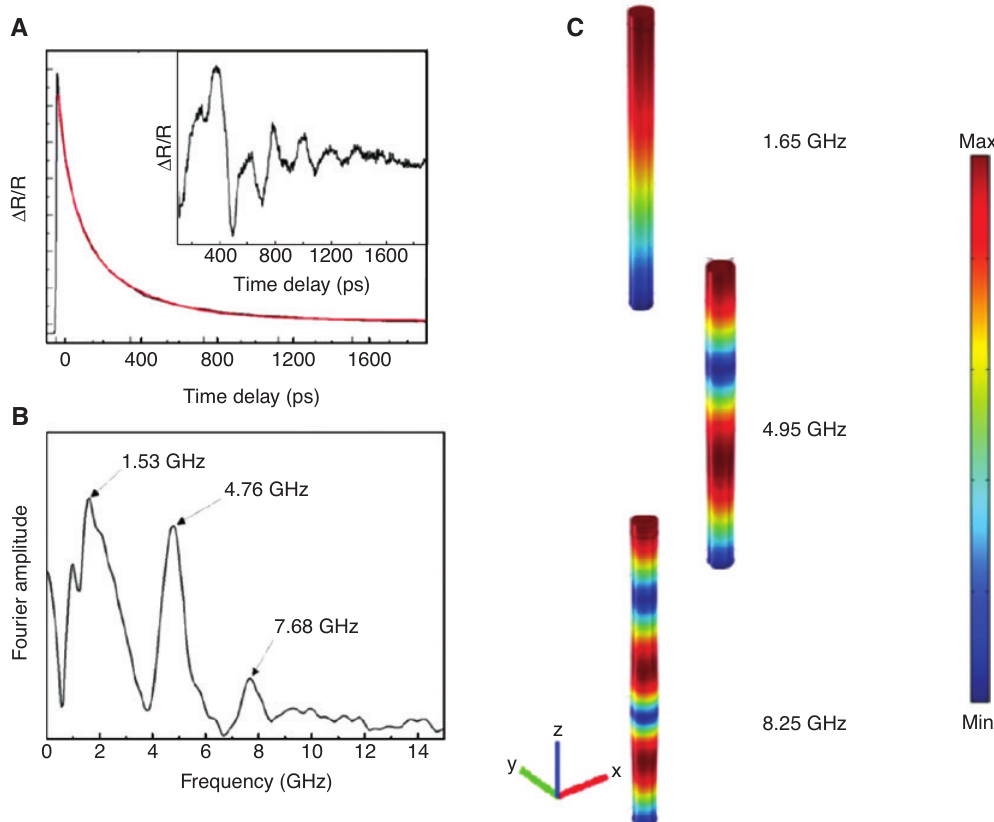
Figure 13: Extensional modes of GaN nanowires. (A) Transient reflectivity trace with a pump wavelength of 360 nm and a probe wavelength of 720 nm obtained on 100 nm diameter and 1150 nm long GaN nanowires. (Inset) Transient reflectivity with background removed. (B) Fourier transform of transient reflectivity. (C) Normalized displacement fields of the three first extensional modes obtained by FEM simulations. Reproduced from